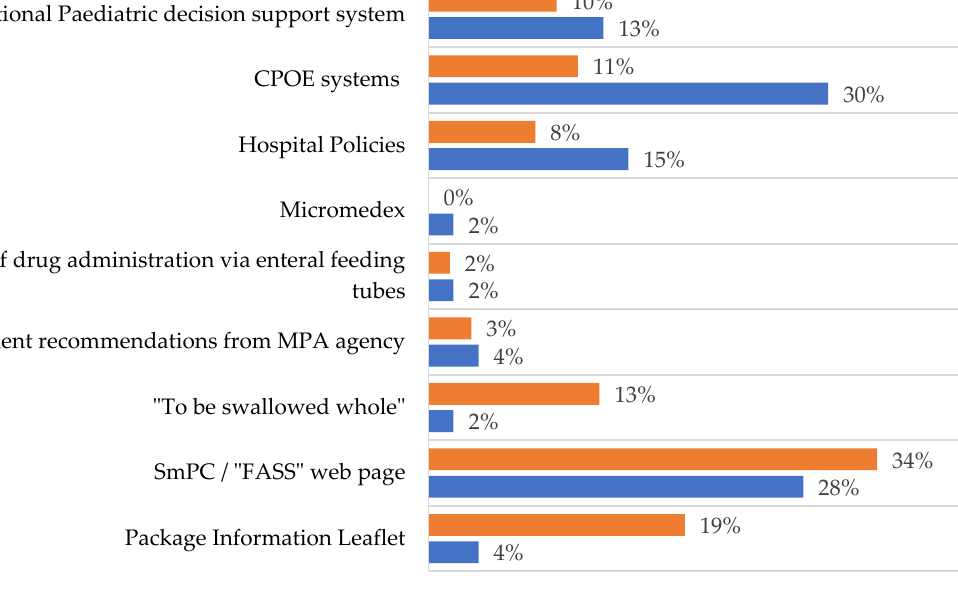
Figure 1. Sources used by paediatricians (blue bars) and nurses (orange bars) to provide additional information in order to ensure that the manipulation procedure is correctly performed. FASS = National web page based on Summary of Product Characteristics [16], “To be swallowed whole” is a guide from the pharmacy company “Apoteket AB” [17], March 2013, no longer updated, Treatment recommendations from the Swedish Medical Products Agency (MPA) [18], Handbook of drug administration via enteral feeding tubes [19], CPOE systems include Cosmic, Cytodose and MetaVision, ePed stands for experience and evidence-based database for paediatric medicines. It is a decision support system for drug treatment with various substances and dosage forms for children [20].